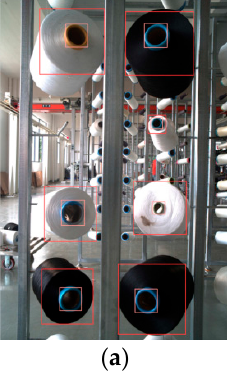
Figure 4. Sample analysis and model training results. ( a ) Samples number. ( b ) Objects coordinate distribution. ( c ) Statistical chart of sample box length-width ratio. ( d ) Training results.